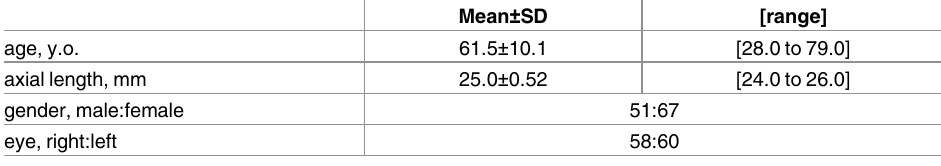
Table 1. Subjects demographics and comparison of variables between groups.